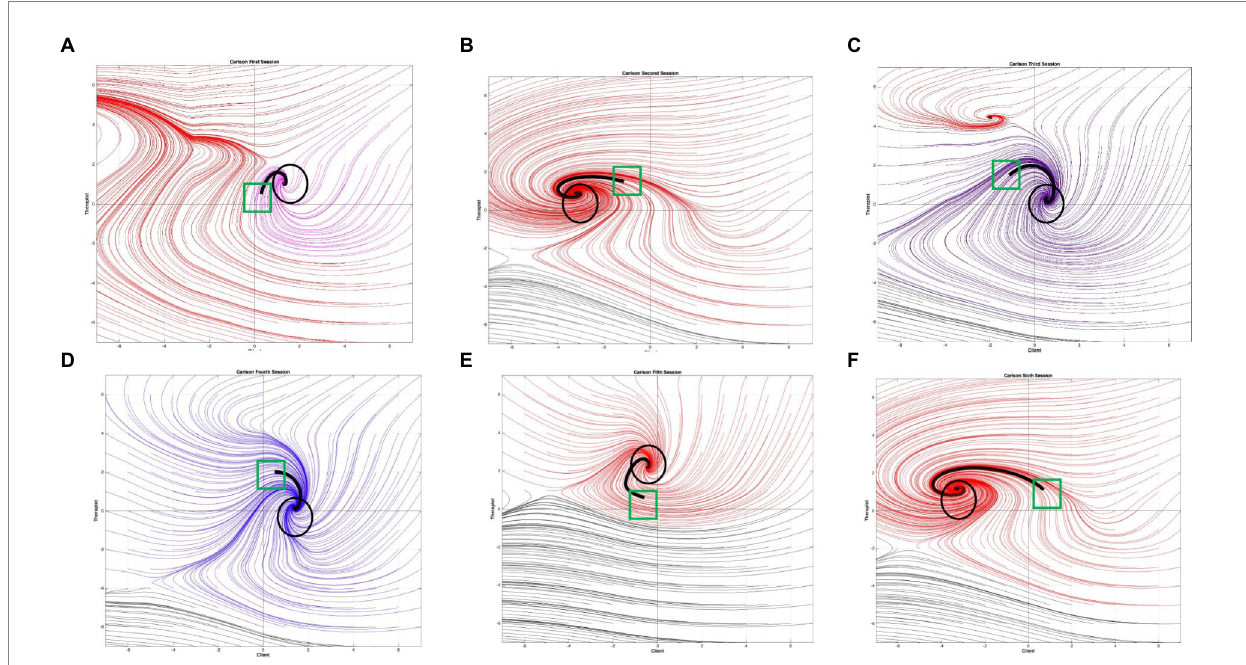
FIGURE 1 Phase portraits of all six sessions of therapy between Jon Carlson and Aime. (A) is the phase portrait for session 1, (B) is for session 2, (C) is for session 3, etc. Beginning coordinates denoted by green circles, and ending coordinates denoted by black circles. Black line is the trajectory that the session likely took based on the starting